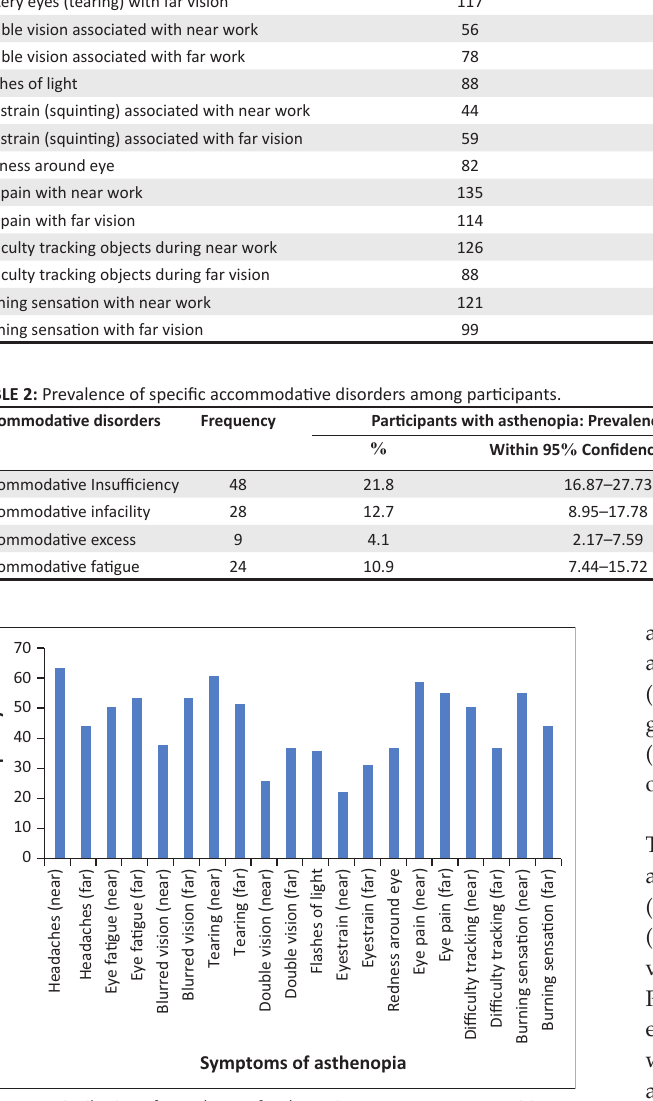
FIGURE 2: Distribution of prevalence of asthenopic symptoms among participants with accommodative disorders.